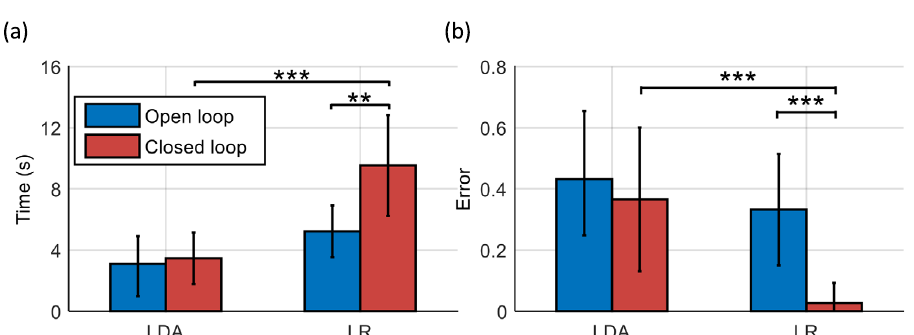
Figure 5. Duration, for that each subject was able to keep the error in the linearly increasing noise scenario below 0.3 units above his/her individual baseline error ( a ). Baseline error increase in the sudden noise scenario ( b ). The plots and error-bars show inter-subject means and standard deviations. The differences between LDA vs. LR and open loop vs. closed loop were tested on statistical significance by Wilcoxon rank sum tests with Bonferroni correction and significant differences are marked with stars ( * P < 0.05; ** P < 0.01; *** P <